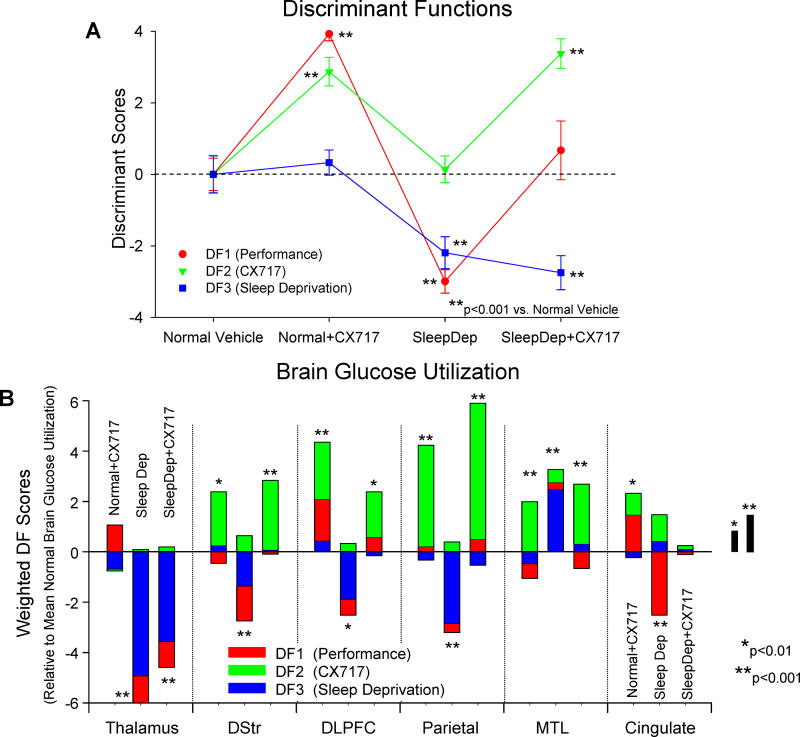
Multivariate CDA of DMS Performance and Brain CMRglc Activity(A) Discriminant functions (DFs 1, 2, and 3) were extracted via CDA from covariance matrices for 12 dependent variables of DMS performance and CMRglc for nine monkeys across the four treatment conditions (see Materials and Methods). Discriminant scores for each DF (different colored curves) were computed for each animal and treatment condition. Scores were rotated via the CDA for orthogonality, and then standardized with mean of zero, standard deviation ± 1.0, relative to the normal vehicle condition for comparison to the other three test conditions and plotted as means (± SEM) across all animals. Positive mean scores for DF1 indicate increased accuracy (i.e., percent correct trials) and decreased latency in DMS performance, while negative scores indicate decreased accuracy and increased latency. Note that scores for DF2 increased when DF1 increased. Scores for DF3 show only decreases associated with both sleep deprivation conditions. Asterisks indicate significant (*p < 0.01, **p < 0.001) difference compared to normal vehicle score for the respective DF.(B) A component of the CDA analysis extracted sources of variance associated with changes in absolute CMRglc (see Materials and Methods) across the six ROIs described in Figures 7 and 8. The length of each bar reflects the total change in CMRglc measured in that structure (i.e., the ROI). Positive scores indicate relative increases in CMRglc within a brain region with respect to their levels in the normal vehicle condition (“0”). Negative scores indicate relative decreases in CMRglc within a brain region. Each colored segment of the bar indicates the proportion of total CMRglc variance contributed by each of the respective DFs (A) for a given treatment condition: DF1 (orange), DF2 (green), DF3 (blue). Asterisks indicate conditions with significant (*p < 0.01, **p < 0.001) differences in CMRglc compared to normal vehicle. Height of small black bars at right indicate significance levels for colored segments of bars.DOI: 10.1371/journal.pbio.0030299g009